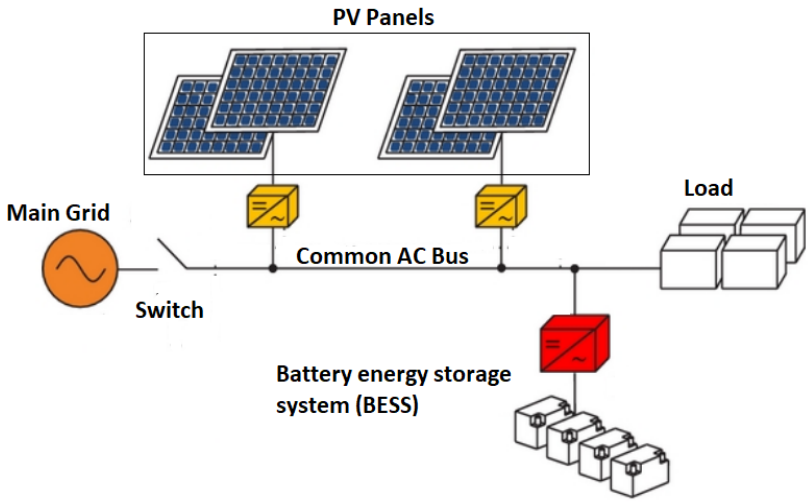
Figure 1. Illustration of microgrid model with BESS.